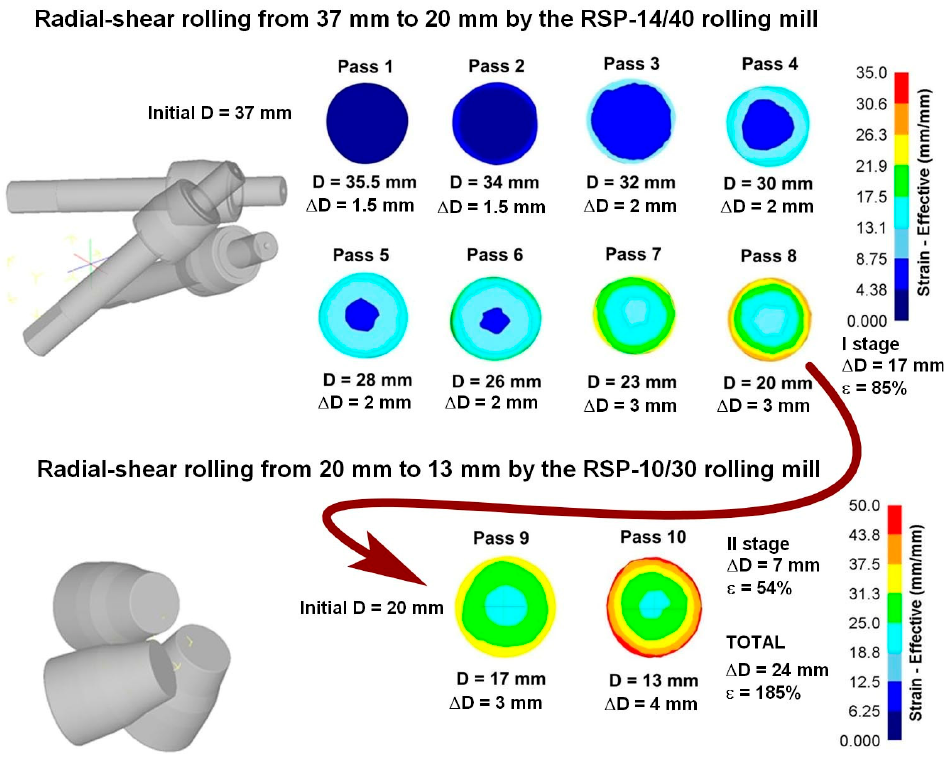
Figure 5. Equivalent strain through 10 passes of radial shear rolling at RSP-14/40 and RSP-10/30 rolling mills.